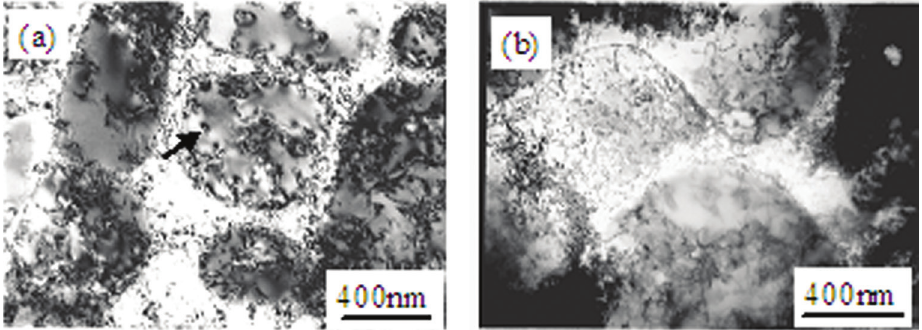
Fig. 2: Dislocation morphology of aged alloy after tensile fracture at low temperatures: (a) 20 °C, (b) 600